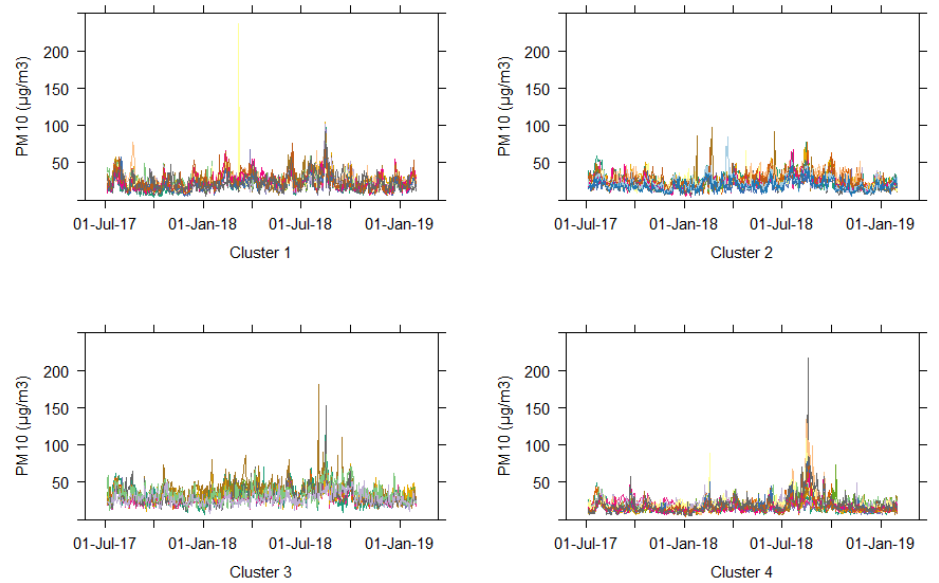
Figure 5. Time series plots for each cluster formed based on DTW and PAM for daily average PM 10 time series data.